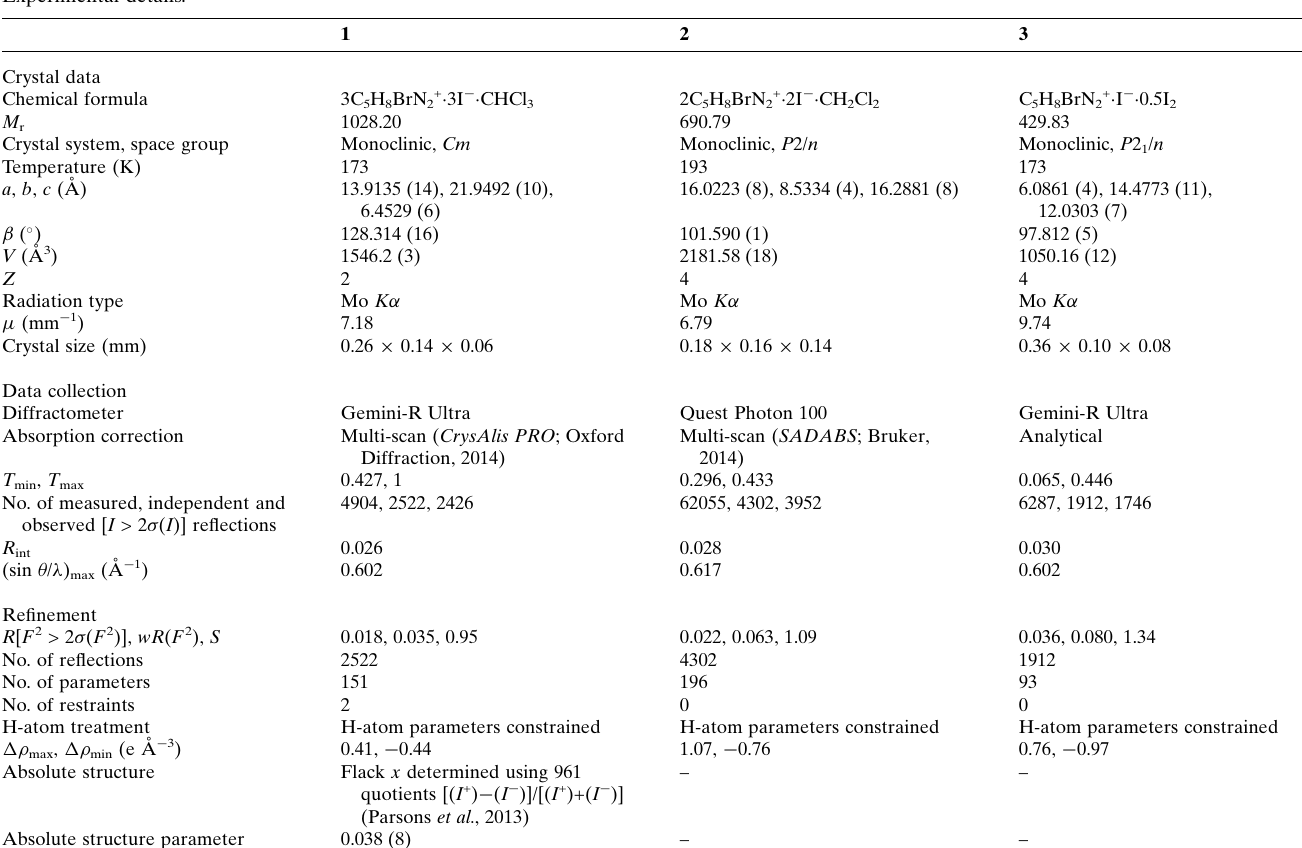
Table 4 Experimental details.